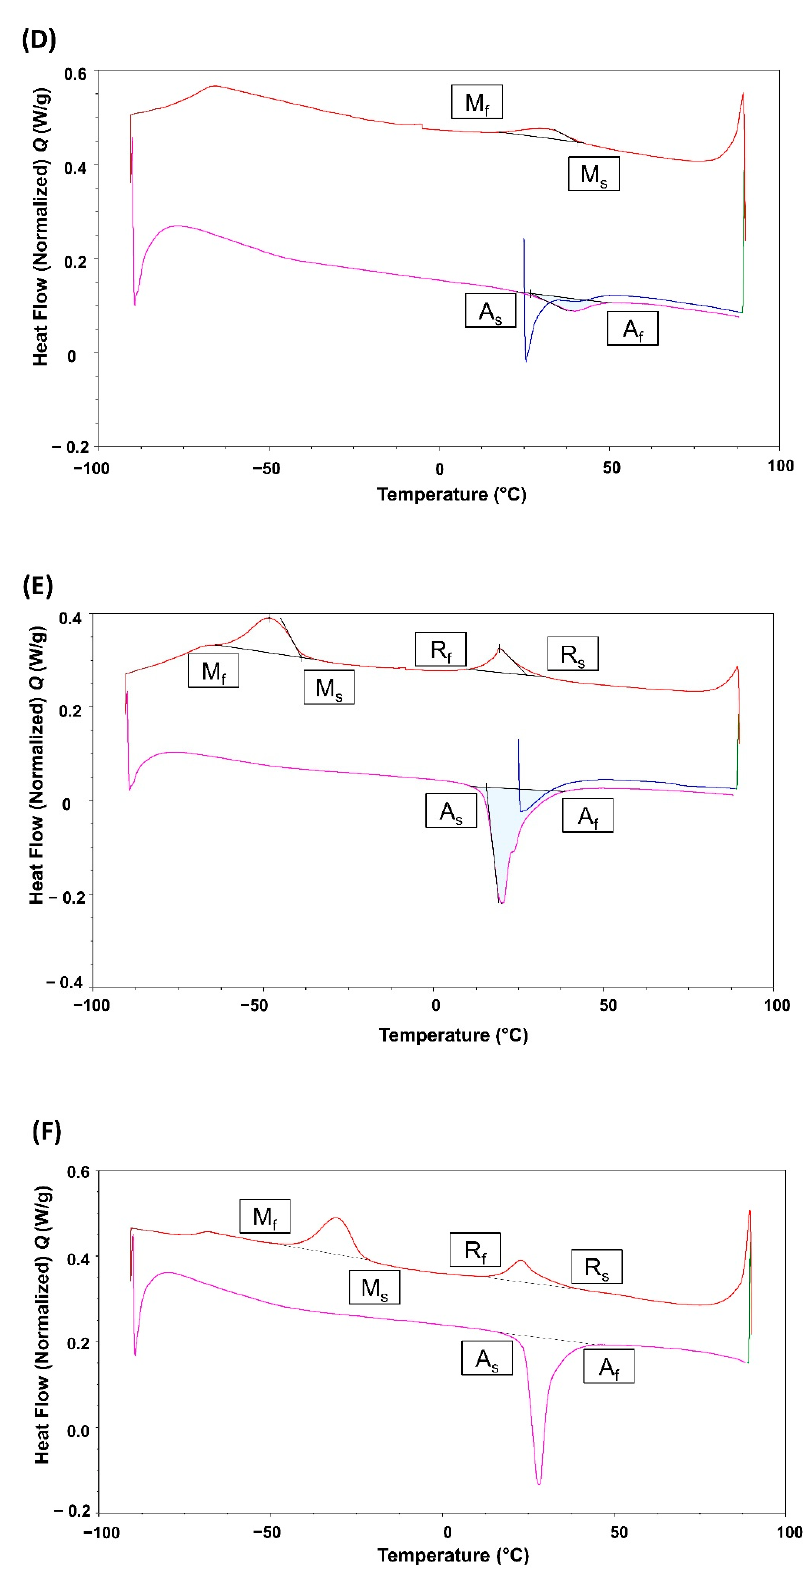
Figure 3. DSC plots of tested new files. ( A ) PathFile; ( B ) RaCe; ( C ) RaCe Evo; ( D ) HyFlex EDM; ( E ) TruNatomy Glider; ( F ) V Taper 2H. A s and A f , Austenitic transformation starting and finishing temperatures; R s and R f , R-phase transformation starting and finishing temperatures; M s and M f , Martensitic transformation starting and finishing